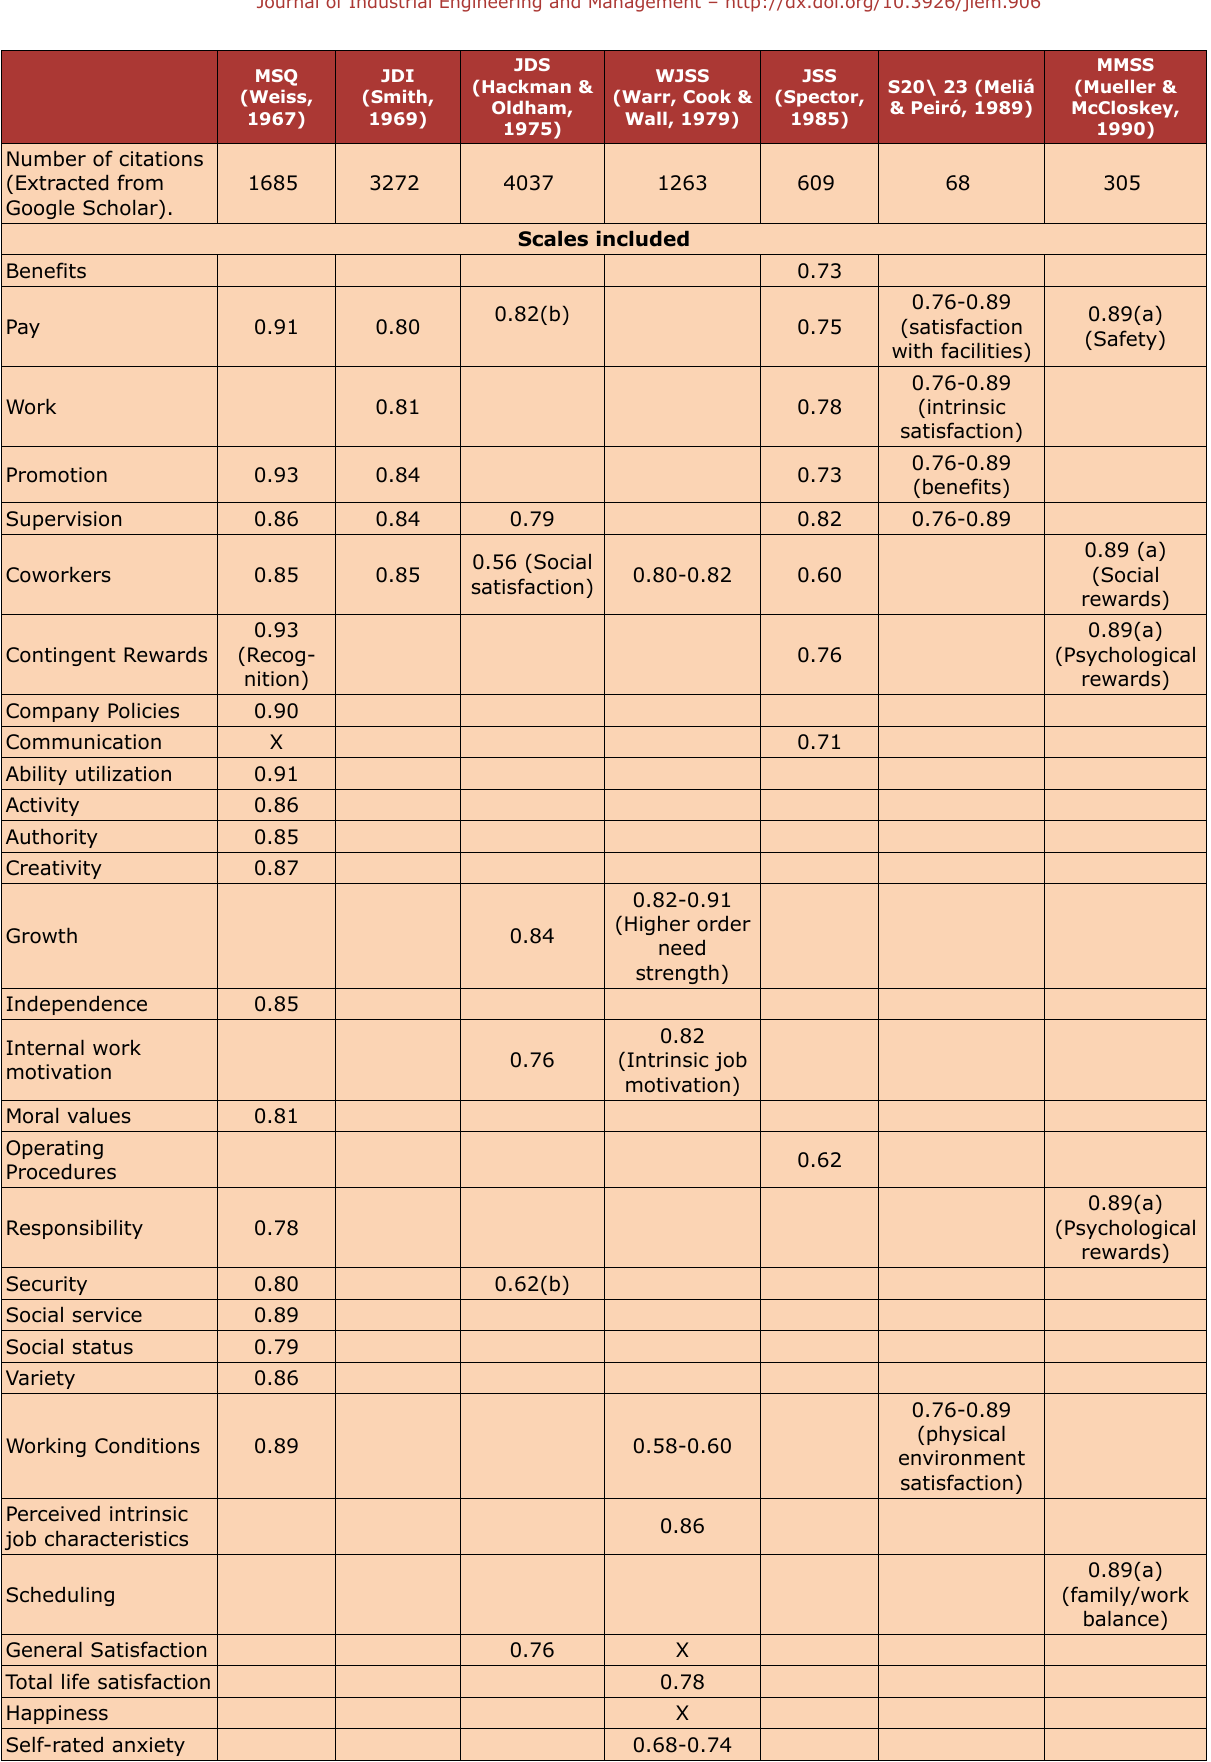
Table 1. Satisfaction scales, times cited and internal consistency (Cronbach alpha). (a)Total